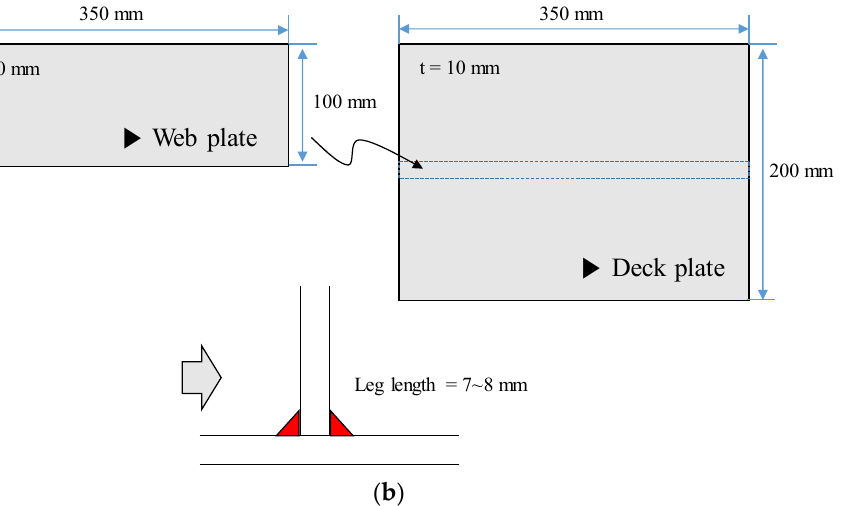
Figure 2. Design of specimen (dimension and welding detail): ( a ) Dimension and joint detail of butt welding; ( b ) Dimension and joint detail of fillet welding.